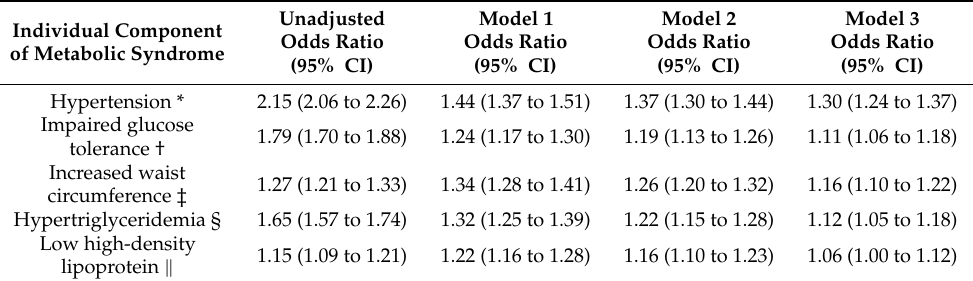
Table 3. Odds ratios for self-reported kidney stone disease by individual components of metabolic syndrome (n = 121,579).